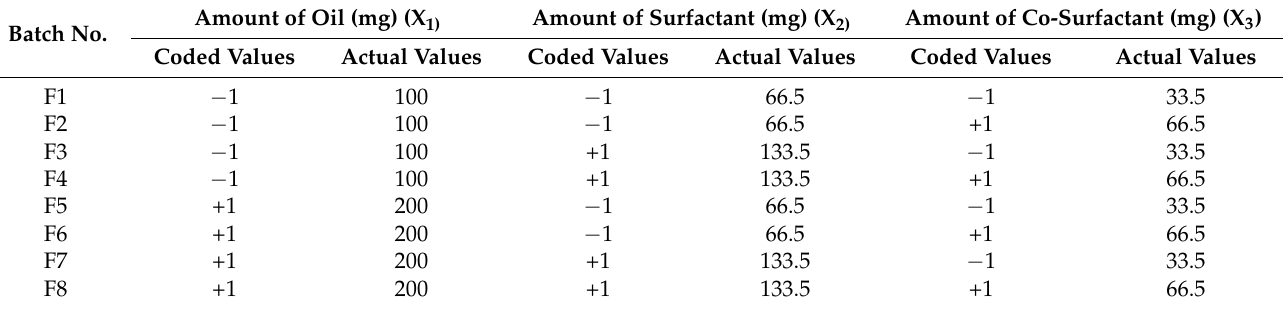
Table 1. 2 3 Full factorial design indicating both independent and dependent